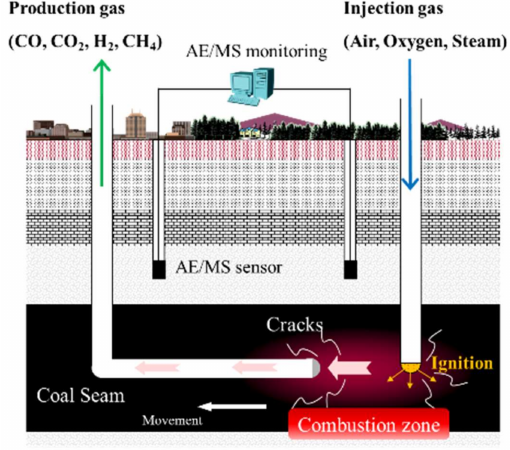
Figure 1. Traditional Underground Coal Gasification (UCG) process with monitoring system.